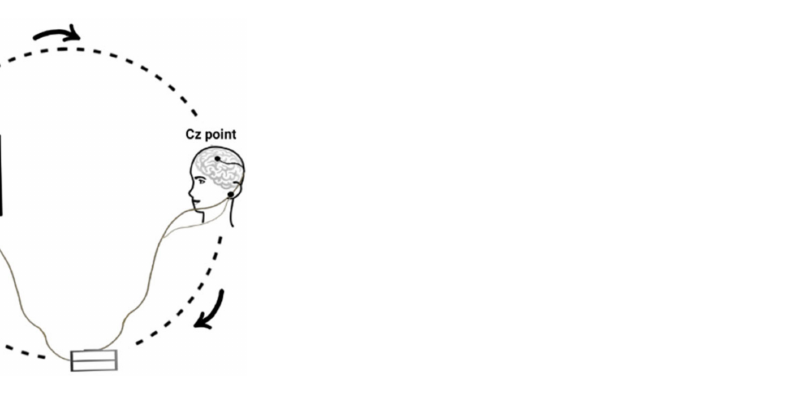
Figure 3. The schematic illustration of the neurofeedback